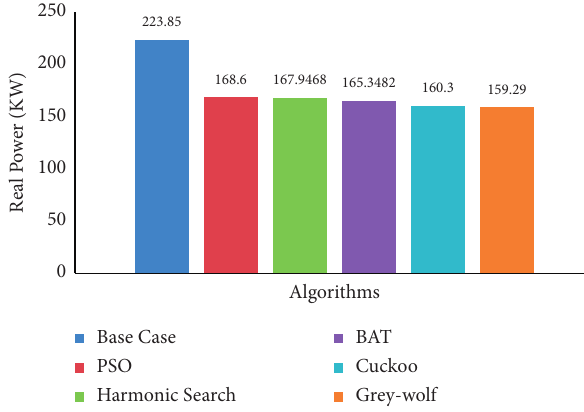
Figure 13: comparison of Real power losses for different techniques.